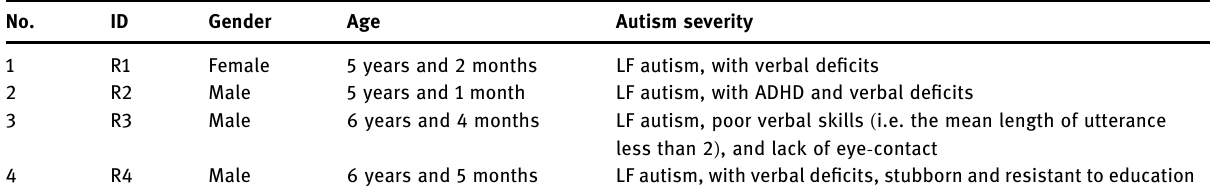
Table 1: The children ’ s details